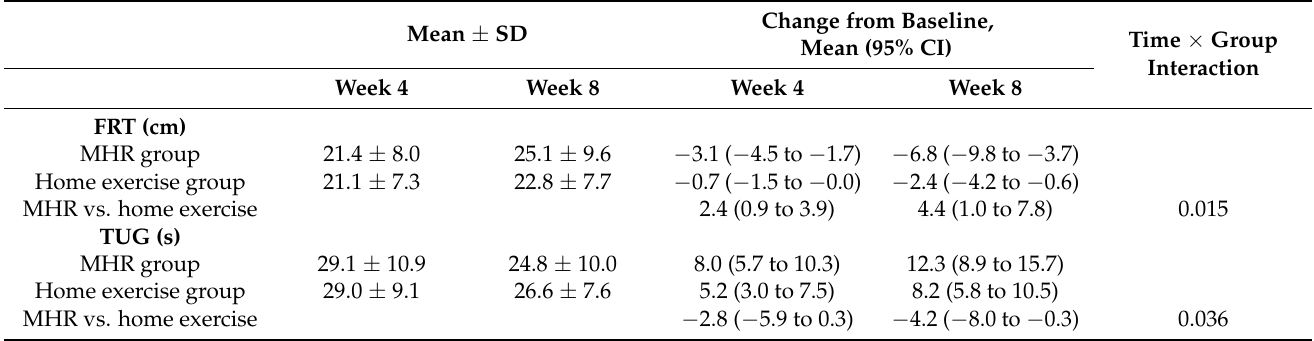
Table 2. Primary outcomes for adjusted and unadjusted analyses between-group differences.